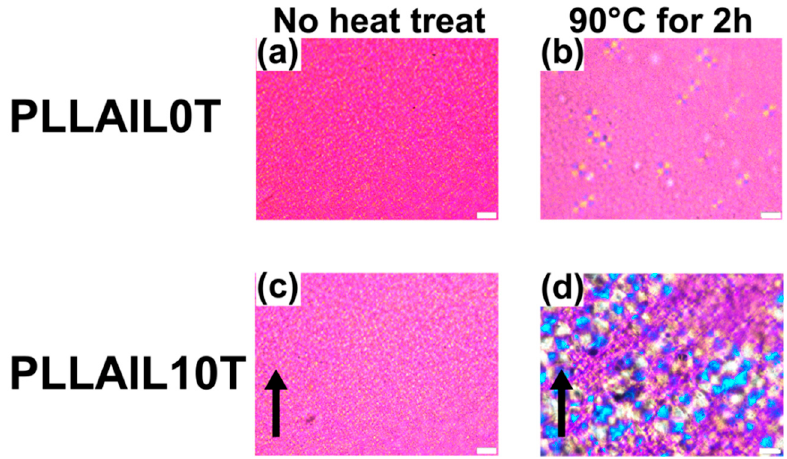
Figure 9. Polarization microscope images of PLLA films: ( a ) PLLAIL0T, ( b ) PLLAIL0T2, ( c ) PLLAIL10T, and ( d ) PLLAIL10T2. The black arrow indicates the direction of the magnetic field. White bar = 50 μ m.